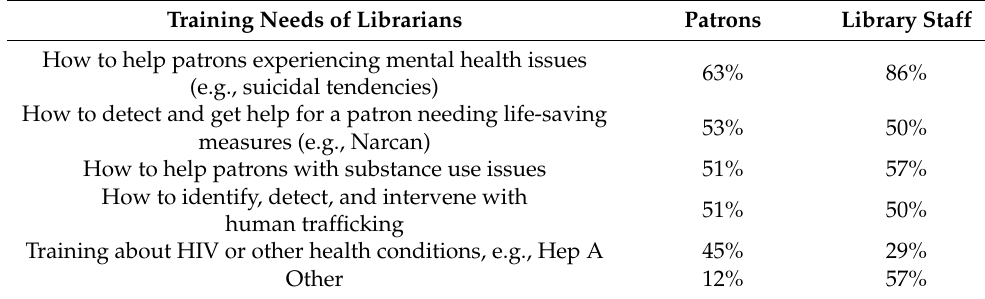
Table 2. Perceived training needs of the librarians ( n = 63; 49 Patrons, 14 Library